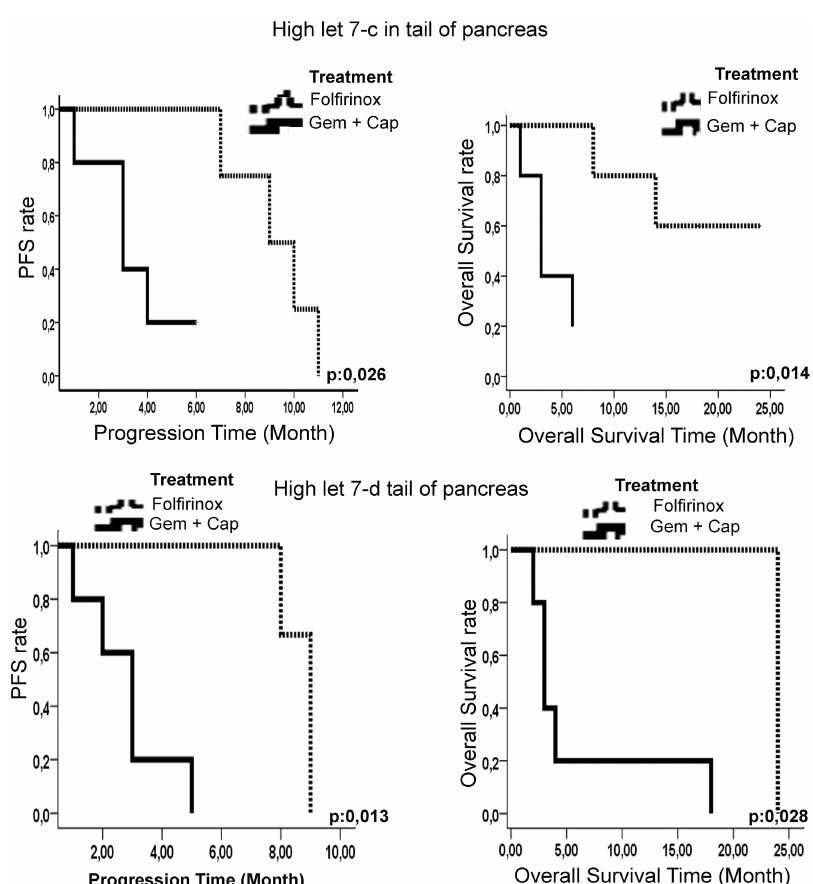
Figure 3. Progression-free survival (PFS) and overall survival (OS) of the high let-7c and let-7d Gem + Cape and FOLFIRINOX arms with pancreatic cancer of tail origin. Gem + Cape, gemcitabine + capecitabine. Table 3. The Relationship Between Median Progression-Free Survival and the Anatomical Origin of Pancreatic Cancer in Serum Low and High-Level Let-7c and 7d FOLFIRINOX and Gemcitabine + Capecitabine Treatment Groups Median Progression-Free Survival (Months) Factor